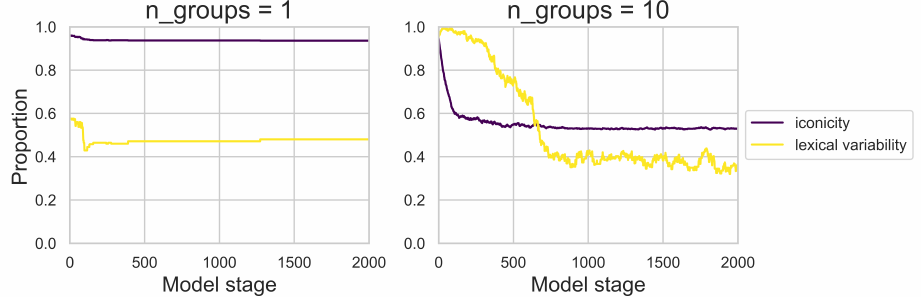
Figure 9. The mean lexical variability and iconicity over the 2000 model stages for one run with 1 group ( left ) and 10 groups ( right ). With all agents belonging to the same group ( n_groups = 1), the degree of iconicity remains high, and the mean lexical variability across the population remains relatively constant, with more than half of the forms across the population being different. With 10 groups that agents could be assigned to ( n_groups = 10), the degree of iconicity drops and then stabilizes slightly above 0.5, with 0.5 representing an unstructured relationship between the bits of the form and culturally salient features. The mean lexical variability across the population drops sharply and then continues to drop slowly, indicating that forms become more and more uniform in the population over